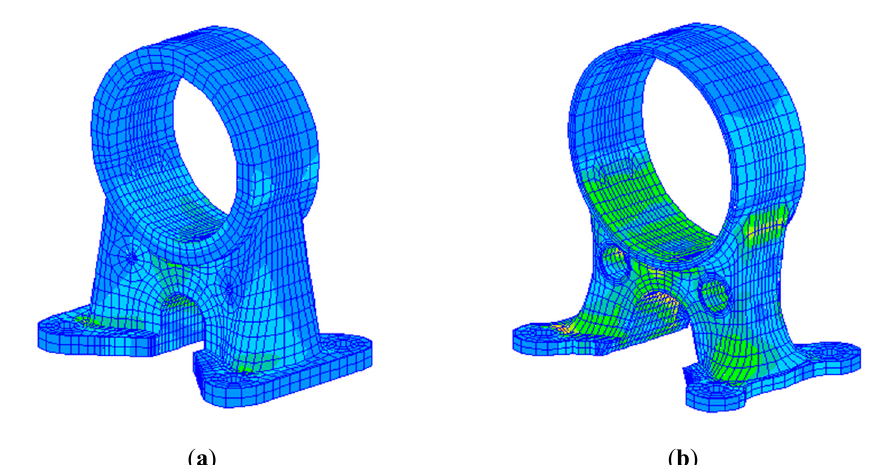
Figure 11. Stress distributions of engine mount bracket. ( a ) Initial shape, ( b ) Optimum Shape.